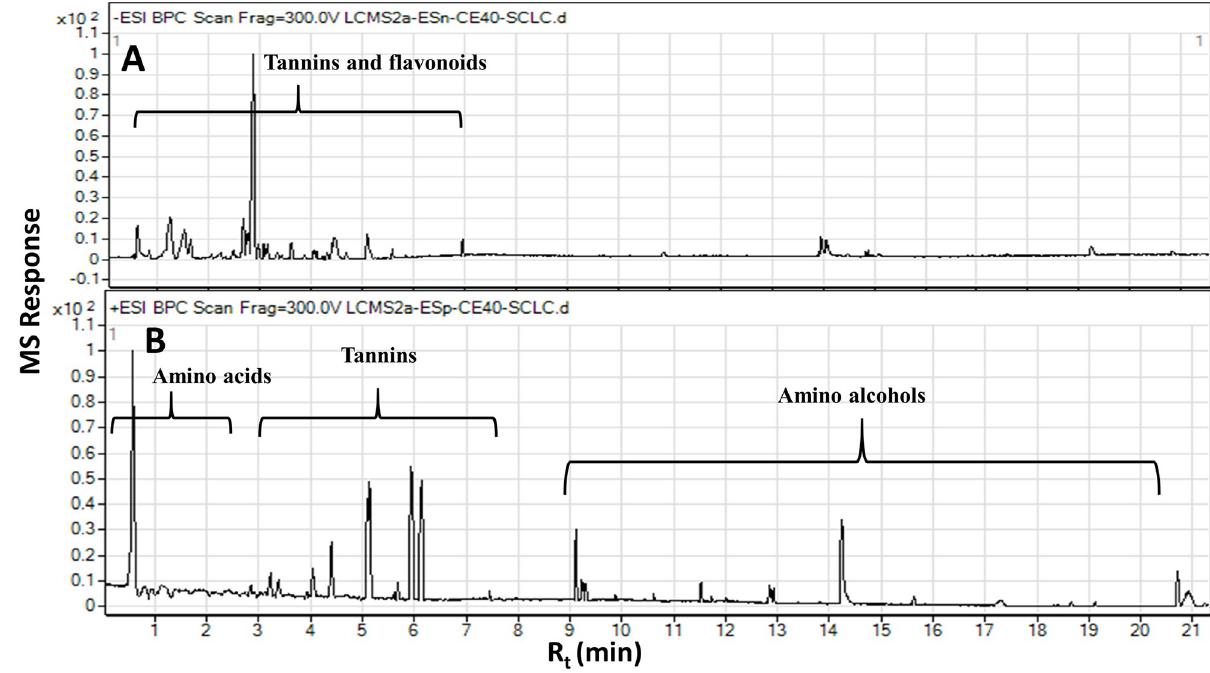
Fig 1. Representative UPLC-MS base peak traces analyzed in the (A) negative ion mode and (B) positive ion mode of S . coriaceum leaf crude extract with peaks mainly due to tannins, flavonoids, amino acids and amino alcohols.